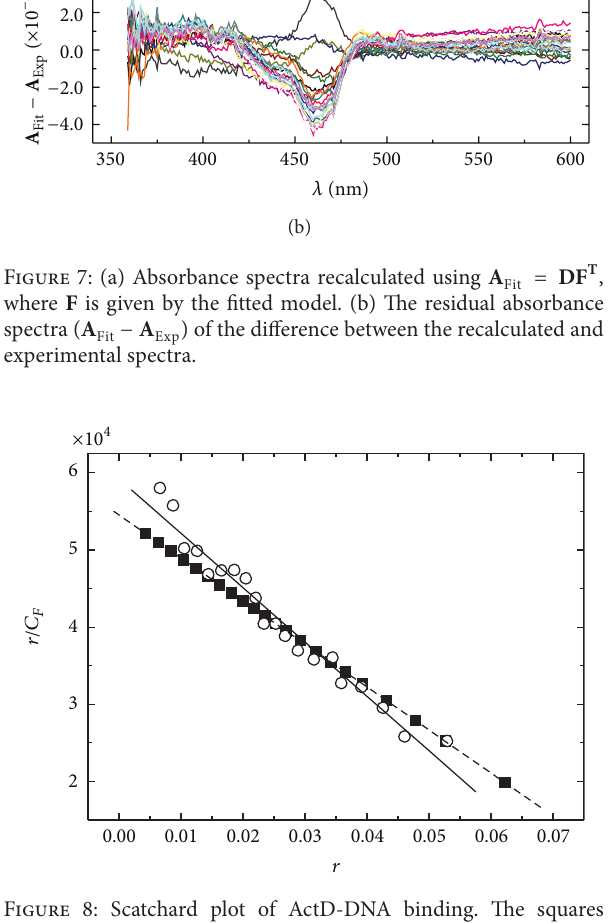
Figure 8: Scatchard plot of ActD-DNA binding. The squares and circles represent the SVD binding and standard procedures, respectively.Theone-sitemodelfittingusingtheScatchardplotgives 𝐾 = 7.0 ± 0.5 × 10 5 M −1 and 𝑛 = 12 ± 1 bp/(bound drug), while the SVD binding analysis gives 𝐾 = 5.57 ± 0.07 M −1 × 10 5 M −1 and 𝑛 = 10 bp/(bound